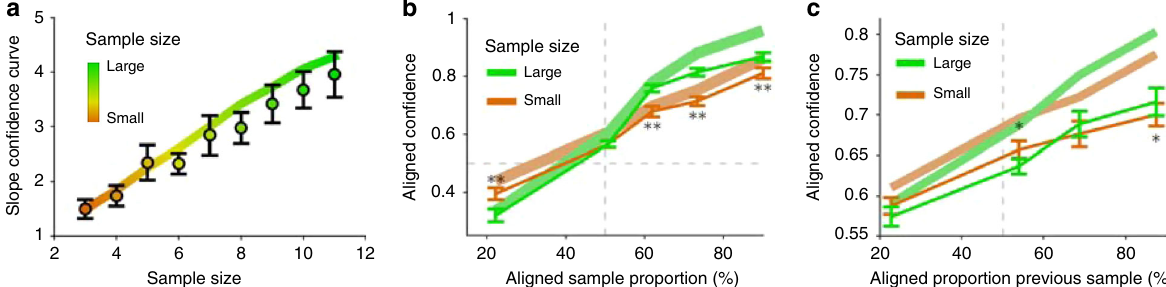
Fig. 6 Sample size effects reveal reliability-based information integration. a As in the basic task (Fig. 2b), the slope (data points) of the con fi dence curves over the sample proportion increases with sample size and tightly follows the optimal pattern (solid line). b The modulation of aligned con fi dence with the aligned sample proportion of the current trial is larger when the sample size is high (green) than when it is low (orange). Signi fi cant signed differences of a bin-wise one-sided signed rank test are indicated, *0.01< p ≤ 0.05, ** p ≤ 0.01. c The modulation of aligned con fi dence with the aligned sample proportion of the previous trial is larger when the sample size of the previous trial is high (green) than when it is low (orange), similar to the previous panel. Error bars indicate SEM across participants in a –